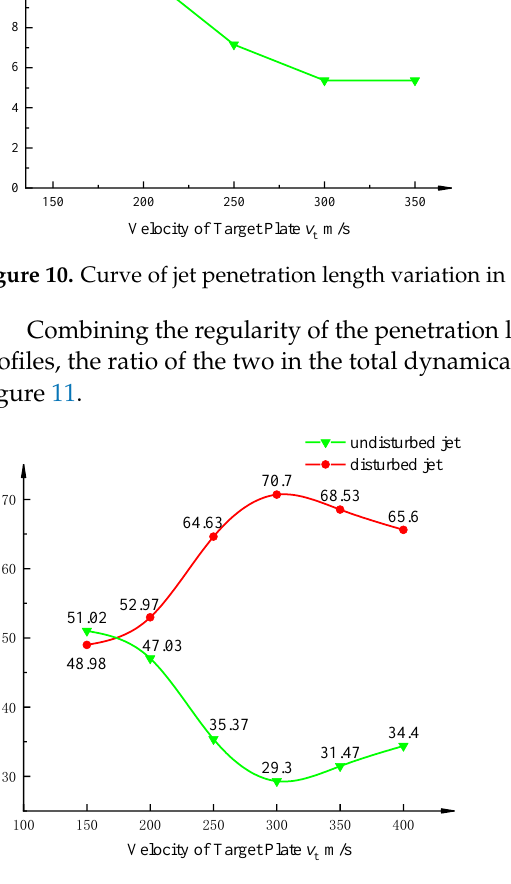
Figure 11. Curve of penetration length ratio of jet in perturbed and unperturbed sections. Figure 11 shows that the ratio of the unperturbed jet to the overall penetration depth definitely decreases at first and then rises as the velocity of the target is increased. The penetration depth ratio of the perturbed jet is reversed. Based on the analysis of the dynamic penetration mechanism, it can be seen that when the moving speed of the target plate continues to increase, the interference time will advance, resulting in fewer and fewer jets in the undisturbed section, which directly affects the proportion of this part of the jet in the total penetration distance. At the same time, the penetration distance of the perturbed jet increases proportionally to the total dynamical penetration. However, as the target speed continues to increase, when the target speed is greater than 300 m/s, the effective length of the disturbed section jet continues to decrease due to the increase in the random moving speed of the effective jet velocity threshold, which makes the penetration ability